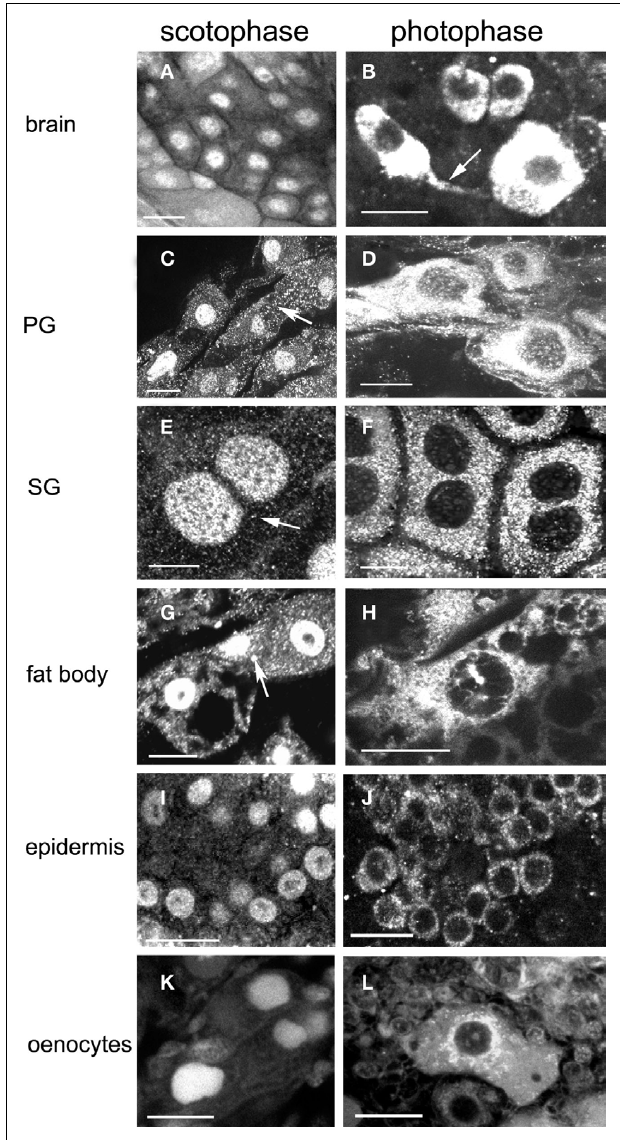
FIGURE 2 | Images show changes in the subcellular distribution and relative intensity of EcR immunofluorescence in the nucleus and the cytoplasm between scotophase (left column) and photophase (right column) during larval–adult development in brain neurons (A,B), PG cells (C,D), SG cells (E,F), fat body cells (G,H), epidermal cells (I,J), and oenocytes (K,L). Arrow in (B) shows EcR fluorescence in axons. Arrows in (C,E,G) show reduced cytoplasmic fluorescence in scotophase. Scale bars = 10 μ m.